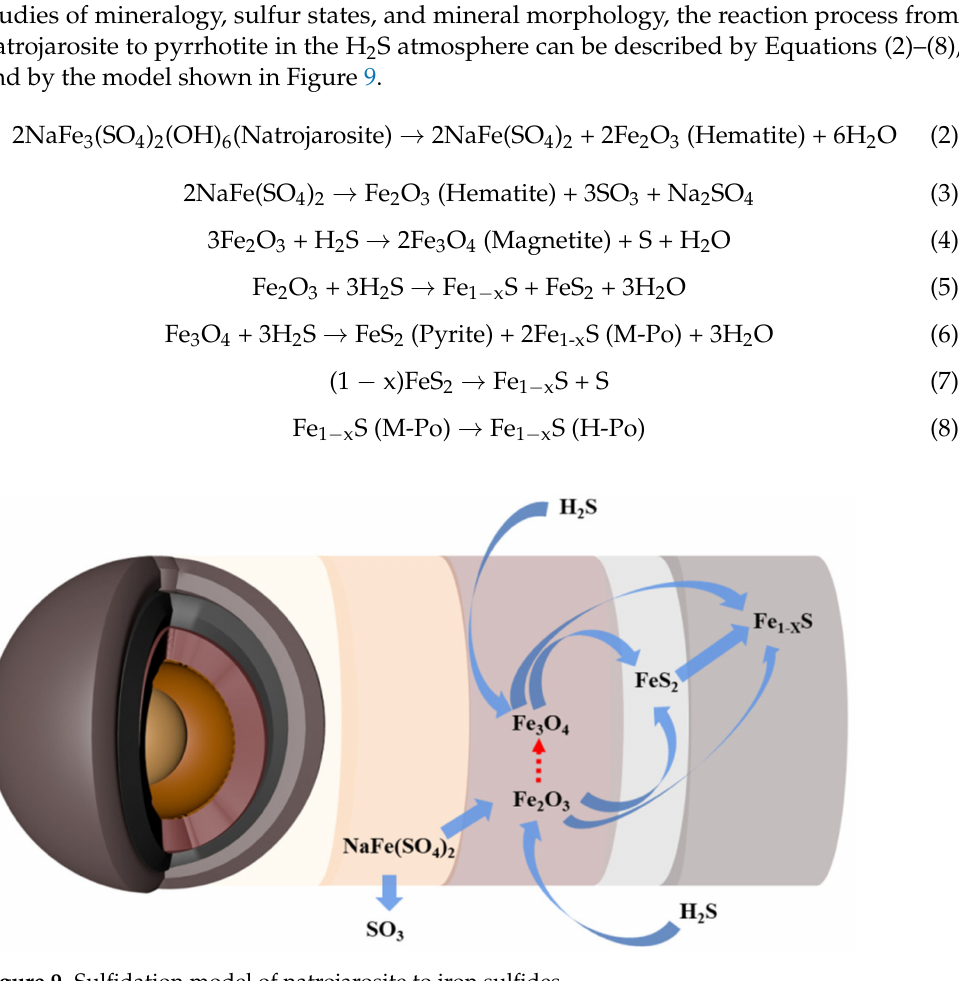
Figure 9. Sulfidation model of natrojarosite to iron